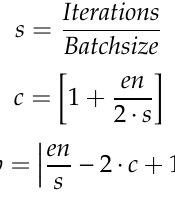
Figure 5. The two-layer Bidirectional Recurrent Neural Network. The outputs of the two corresponding LSTM units are added up in the first layer and sent to the second layer.